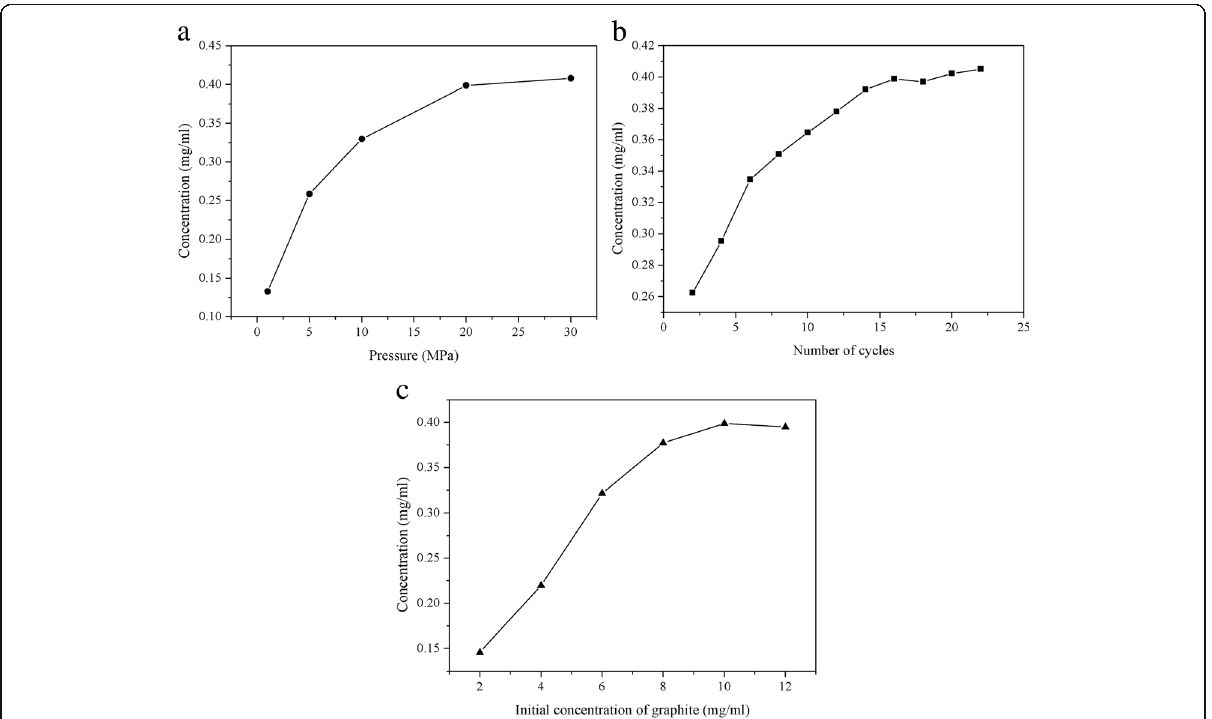
Fig. 8 Effects of operating conditions on the concentration of few-layer graphene. a Working pressure, b number of cycles, and c initial concentration of